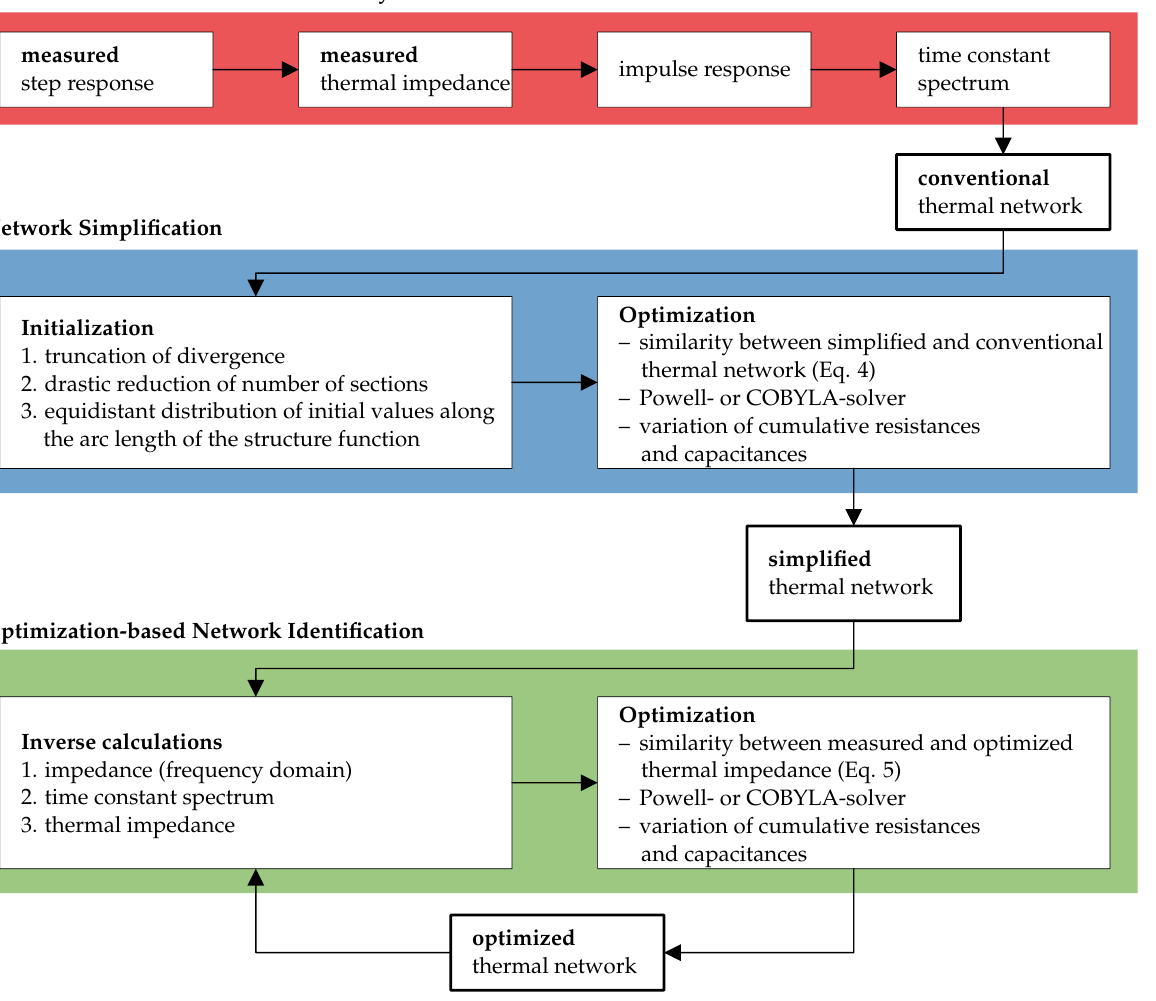
Figure 3. Scheme for optimization-based network identification. First, a network identification by deconvolution is performed. Then, the steps of network simplification and optimization-based network identification